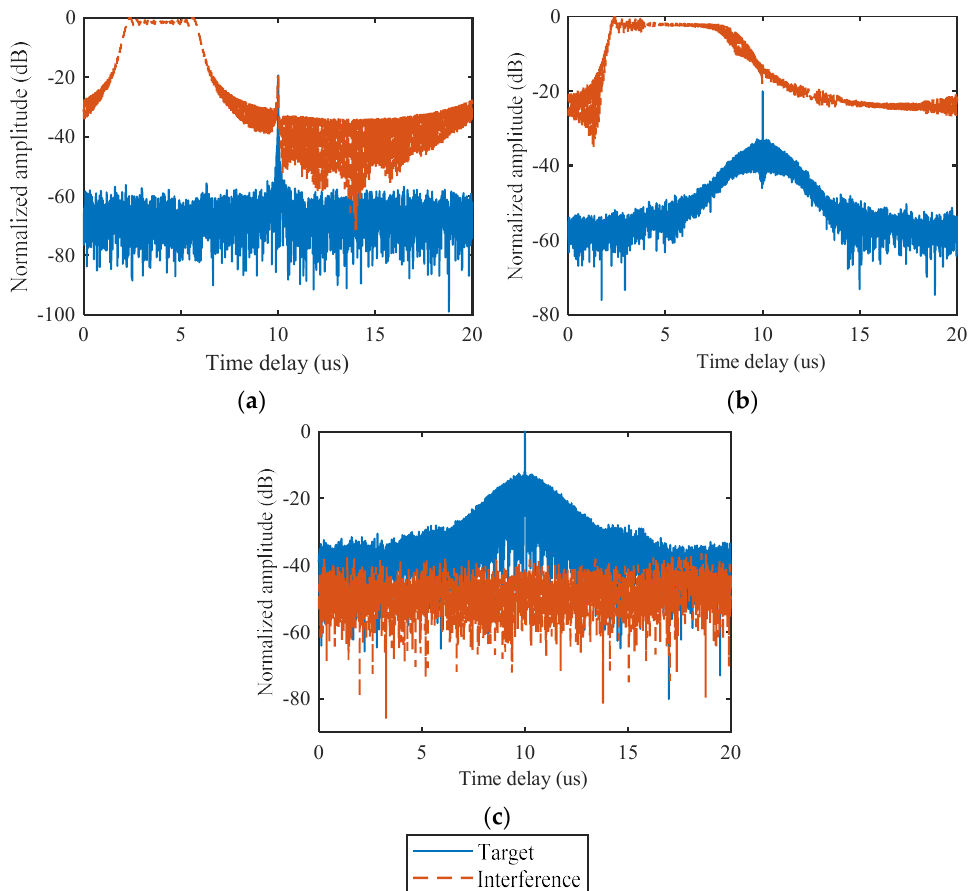
Figure 17. Outputs of the matched filter for the ( a ) LFM waveform, ( b ) waveform designed using sensed interference information, and ( c ) waveform designed using the OS-ELM-FP-based interference frequency prediction result.